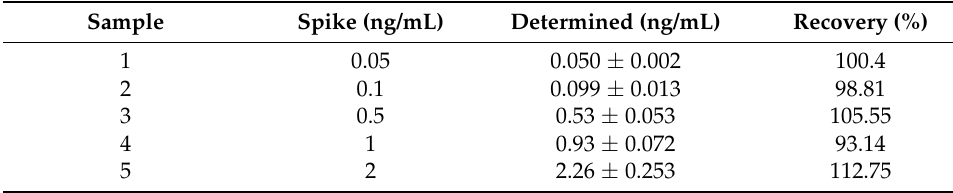
Table 2. Recoveries of OTA in red wine samples by the proposed